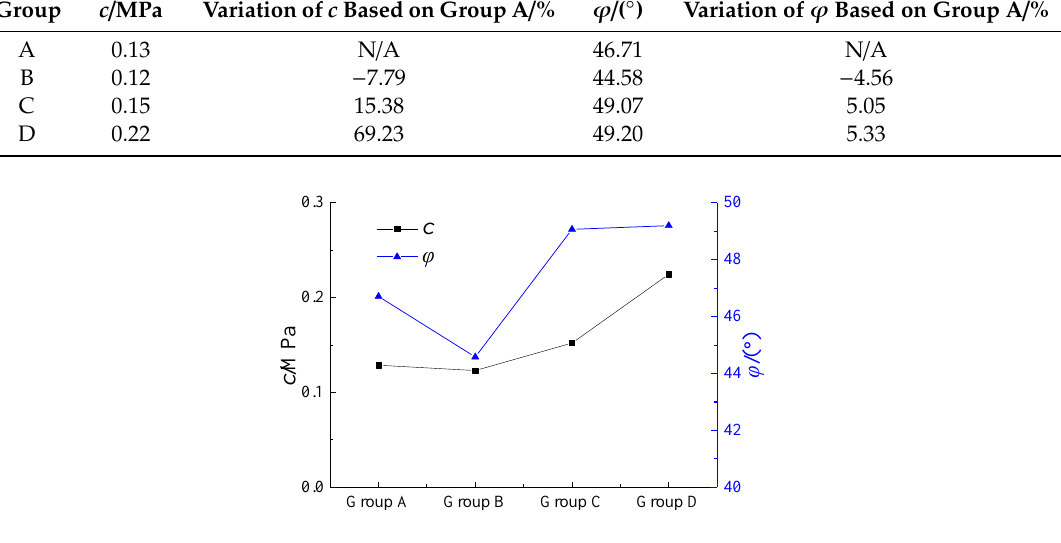
Figure 10. The cohesion and internal friction angle of each group.